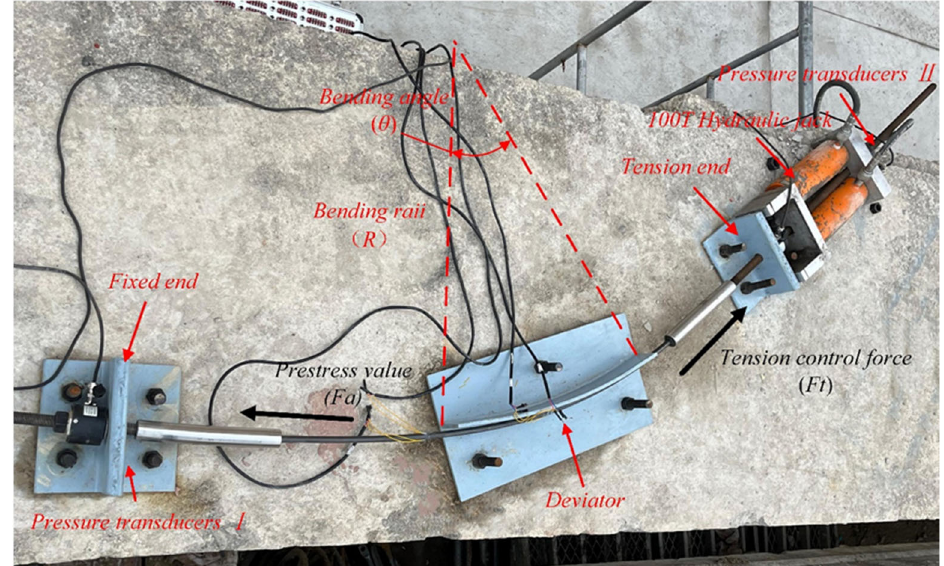
Figure 2. Arrangement diagram of the test device for the single ‐ bending test.